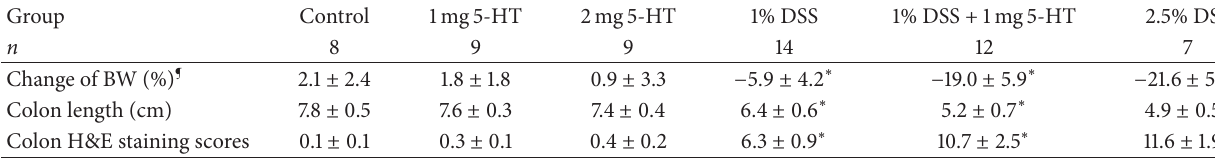
Table 2: The changes of body weight colon length and histopathology of mice in each group. Group